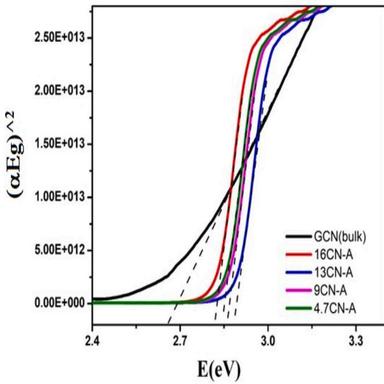
Tauc plot for band gap measurement (a) g-C3N4; (b) 16CN-A; (c) 13CN-A; (d) 9N-A; (e) 4.7CN-A.